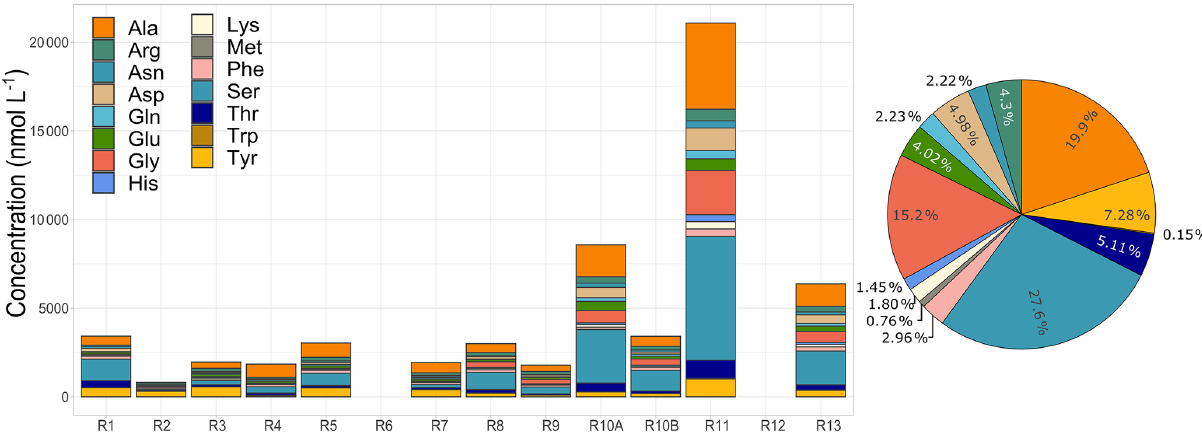
Figure 4. Amino acid concentrations and total average relative contributions observed in cloud waters. R1 to R13 refer to individual cloud samples.